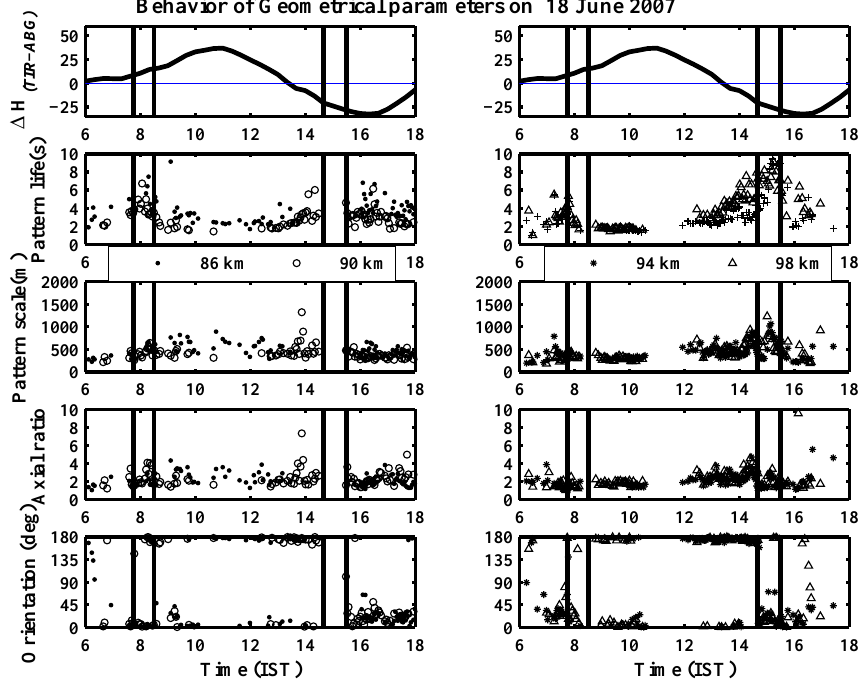
Fig. 3c. Same as Fig. 2c but for 18 June